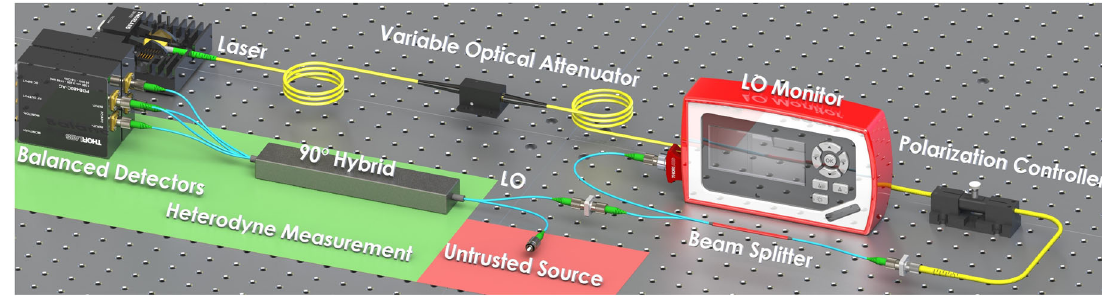
Fig. 2 Schematic representation of the experimental setup. The setup consists of a 1550 nm laser used as a LO, measured in real time. The heterodyne detection is performed by a 90° optical hybrid and a pair of balanced InGaS detectors. The VOA is used during the calibration phase. Only commercial off- the-shelf devices were used